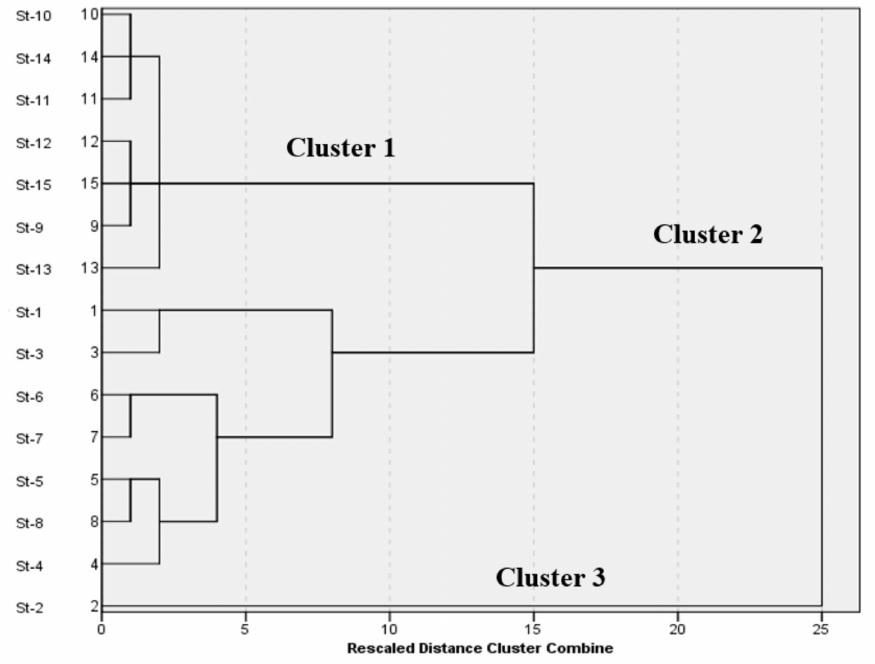
Figure 3. Dendrogram using Ward’s linkage for locational cluster analysis